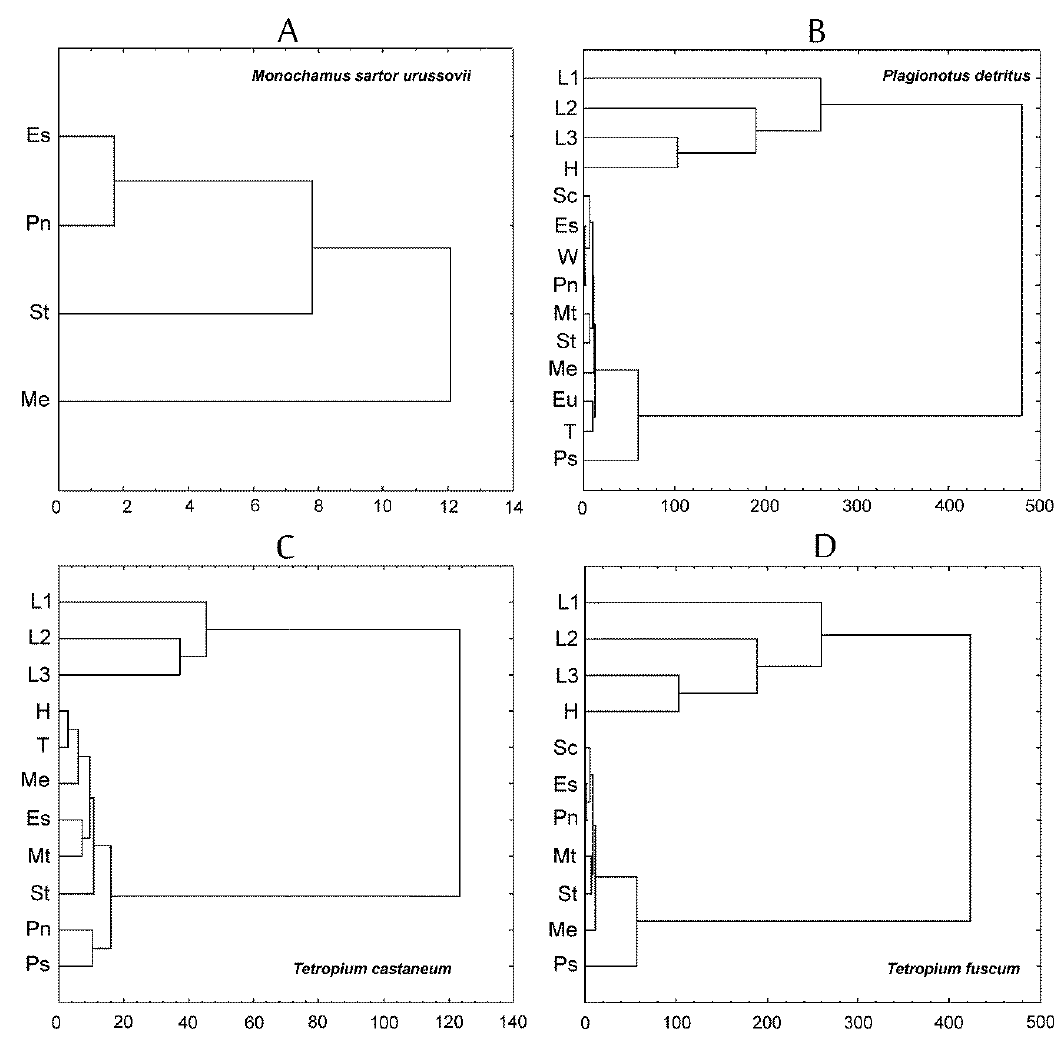
Figure 5. Cluster analysis of distribution of phoretic deutonymphs on various parts of beetles’ body: ( A ) Monochamus sartor urussovii ; ( B ) Plagionotus detritus ; ( C ) Tetropium castaneum , ( D ) Tetropium fuscum ; Distance: Euclidean, cluster method: ward; ( Es ) surface of the elytra; ( Eu ) subelytra; ( H ) head; ( L1 ) forelegs; ( L2 ) midlegs; ( L3 ) hindlegs; ( Me ) mesoventrite; ( Mt ) metaventrite; ( W ) membranous wings; ( Pn ) pronotum; ( Ps ) prosternum; ( Sc ) scutellum; ( St ) abdominal ventrites; ( T ) abdominal tergites.